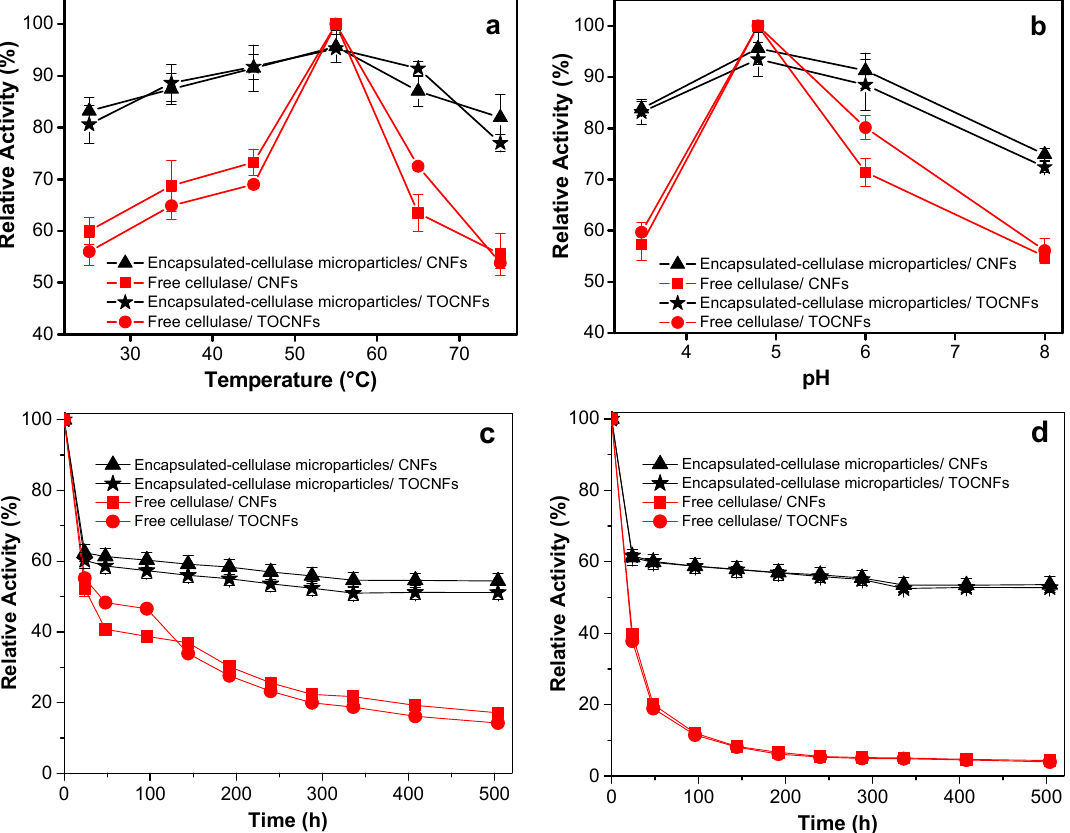
Figure 7. Relative activity of the cellulase immobilized in the alginate microparticles (black curves) and the free enzyme (red curves) for the degradation of CNFs and TOCNFs cellulose nanofibers at: ( a ) di ff erent temperatures after 1 h at pH 4.8; ( b ) di ff erent pHs after 1 h at 55 ◦ C; di ff erent incubation times at: ( c ) conditions of maximum activity of the enzyme (pH 4.8, T = 55 ◦ C, ( d ) conditions resembling more the physiological environment (pH 6.5, T = 37 ◦